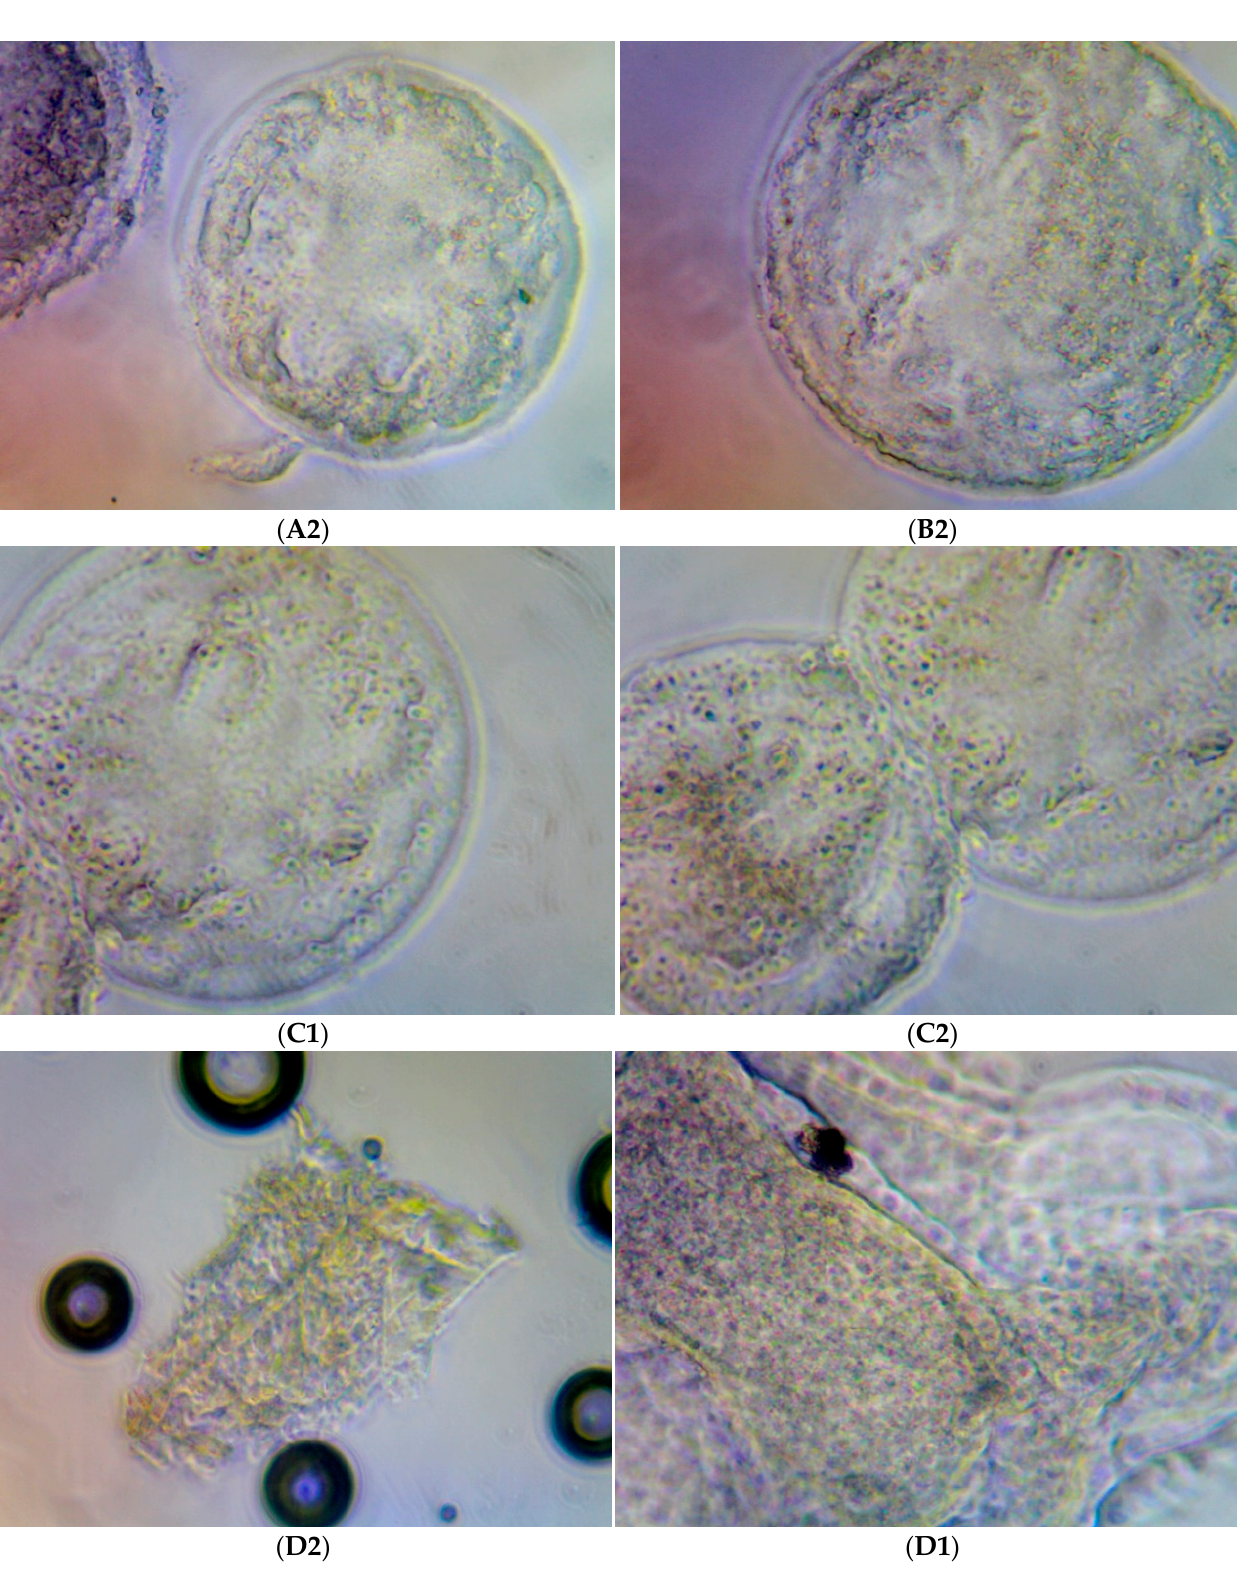
Figure 5. Illustrations from the contrast microscope at 200X magnification: ( A2 ) blastocyst; ( B2 ) ex- panded blastocyst; ( C1 , C2 ) hatched blastocysts; ( D1 , D2 ) trophoblast of a hatched blastocyst (bent structure when fixed to the blade). All DAB-stained in vitro bovine embryos (Experiment 2/IVP Replicate 3) used 20 µg/mL of rHGAL-1 supplementation (Group 3).